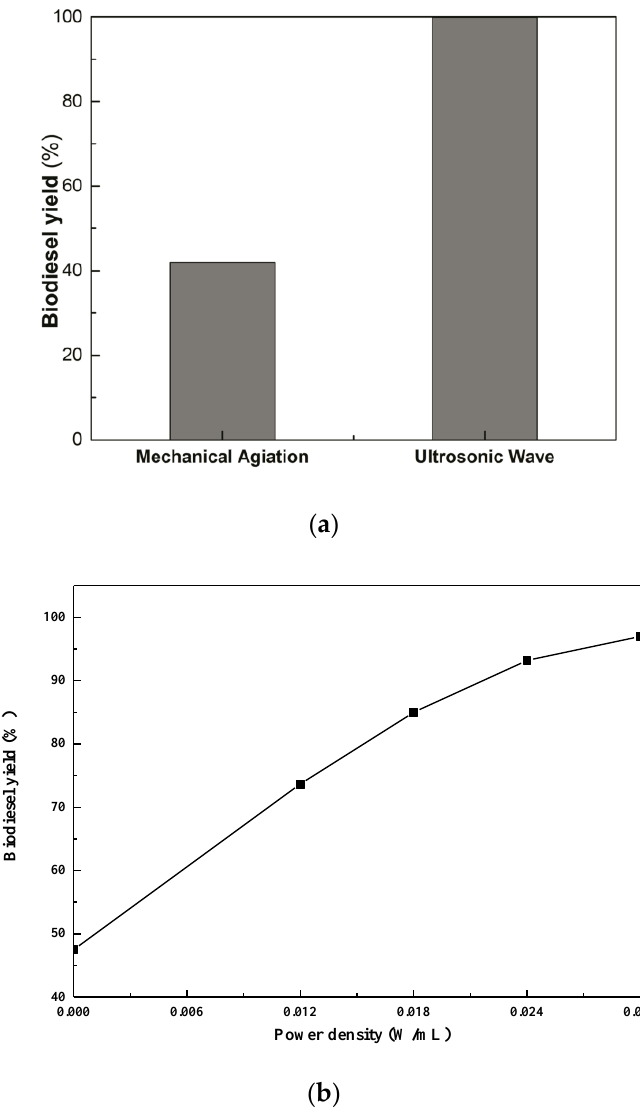
Figure 8. The effects of ultrasonic field aid on transesterification. ( a ) Mechanical agitation vs. ultrasonic field aid; ( b ) Effects of ultrasonic power density on biodiesel yield 12:1 molar ratio of methanol/oil, 6.25 wt% load ratio of K + /HT, and at 60 °C for 5 min.